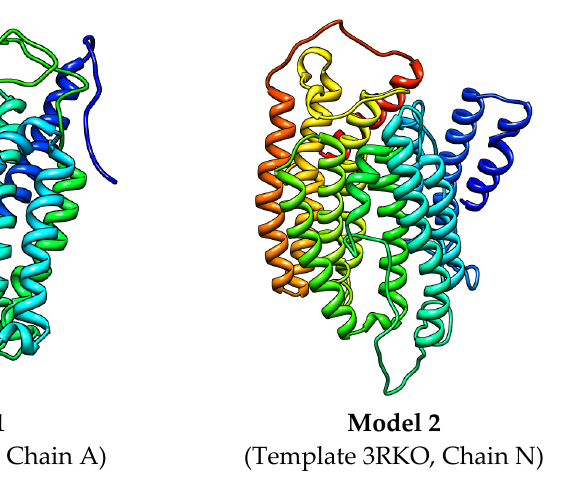
Figure 3. The top three homology models of PfCRT.